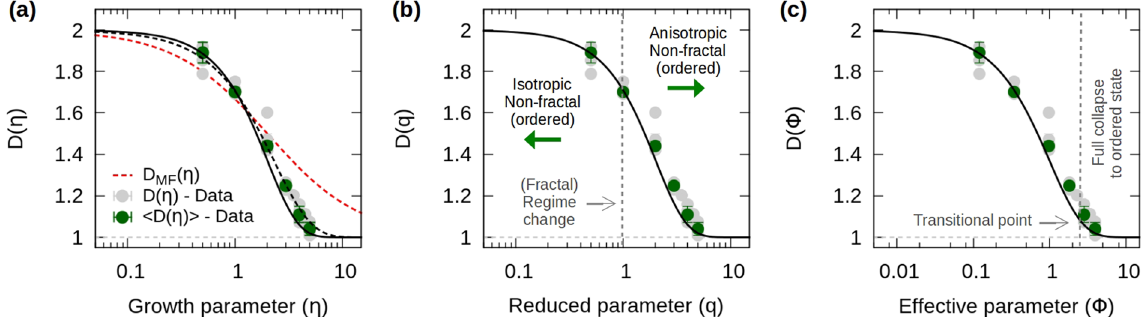
Figure 4. Scaling analysis of the DBM transition. ( a ) Plot of the fractal dimensions D as a function of η for the two-dimensional DBM transition (see Table 1). Here, the failure of the mean-field description is evident (dashed red curve). A better agreement is obtained using equation (2), with η η Φ = Λ χ D D ( , ) / the data with this equation, one obtains Λ ≈ . 0 70 and χ ≈ . 1 26 with η ≈ . 0 66 the analytical analysis and by considering η i = 1, Λ = − . ≈ . 2log(0 71) 0 685 and χ = − Λ ≈ . D 1/(1 / ) 1 52 (solid black curve). ( b ) Maintaining η i = 1 as the transitional point, the analytical solution for D ( q ) is equivalent to that for D ( η ). ( c ) As well, from the analytical expressions, one can obtain the curve Φ D ( ) (see Table 3).